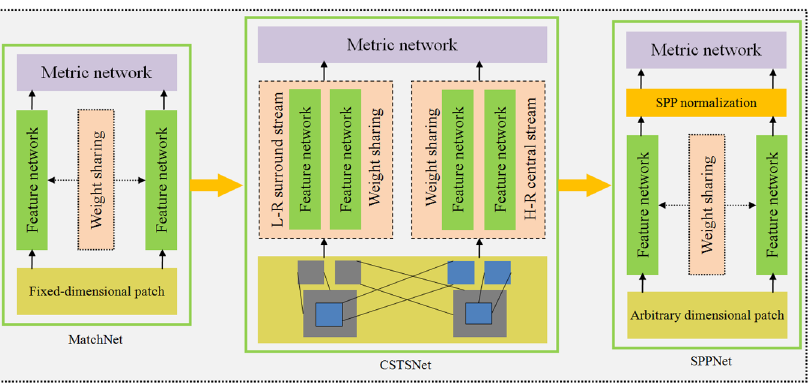
Figure 4. Evolution of representativefeature description networks.